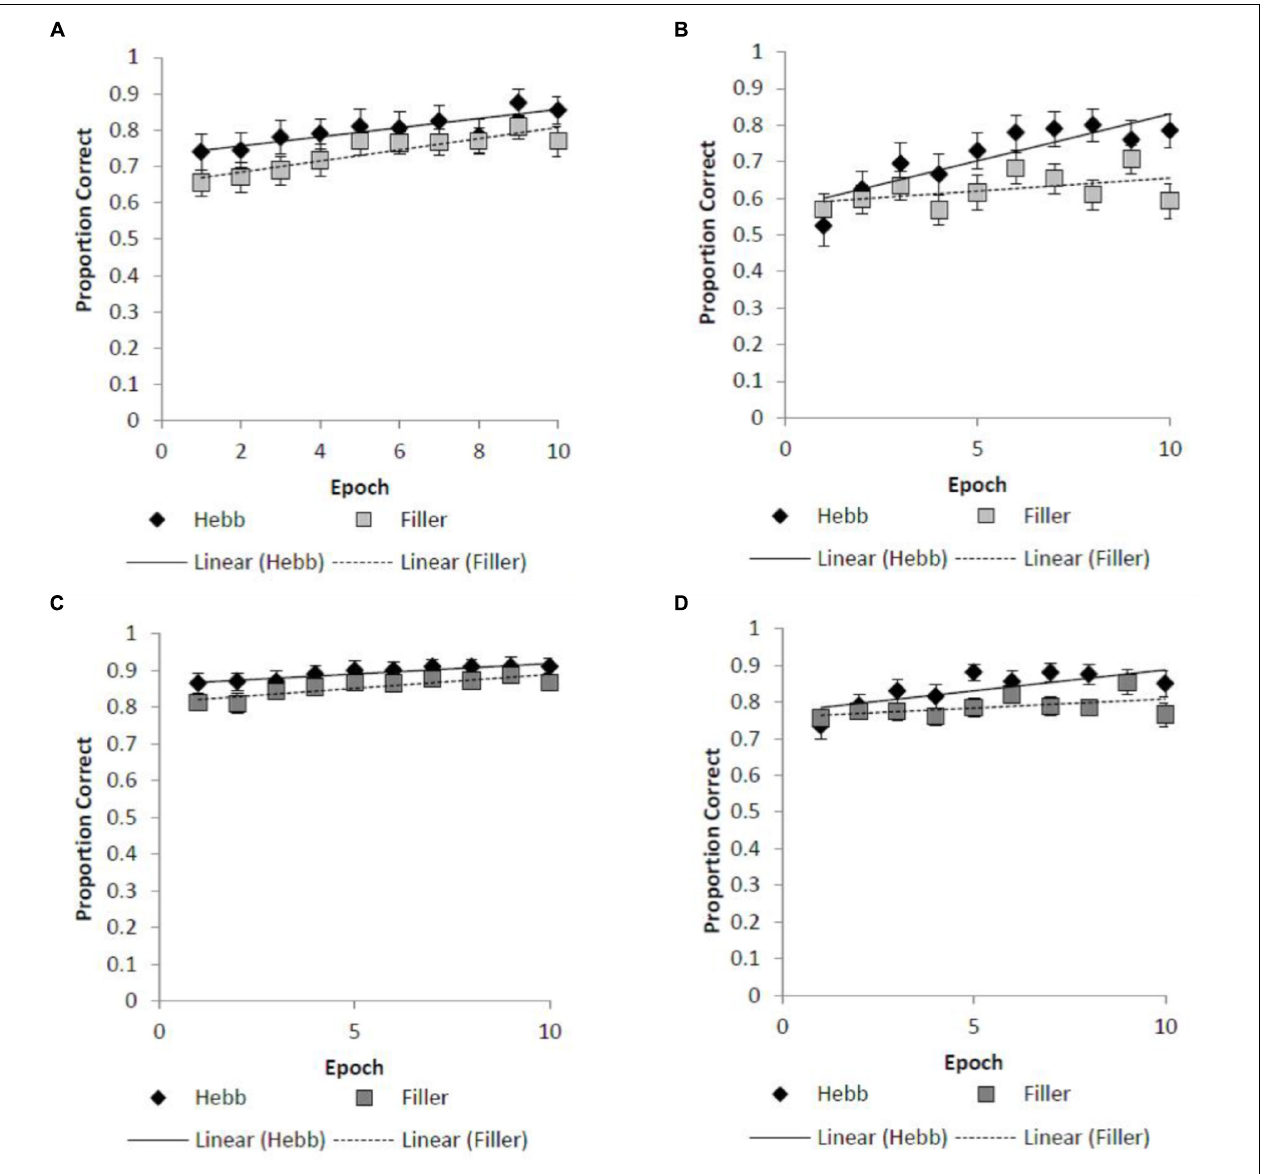
FIGURE 2 | (A–D) Mean improvement for the filler and Hebb inverted face sequences as a function of experimental epoch (1–10) for the (A) absolute position recall scoring under conditions of full-stimulus-overlap, (B) absolute position recall scoring under conditions of no-stimulus-overlap, (C) Levenshtein edit distance scoring under conditions of full-stimulus-overlap, (D) Levenshtein edit distance scoring under conditions of no-stimulus-overlap. Line of best fit depicts the learning gradient for both sequence types. Error bars represent the standard error of the